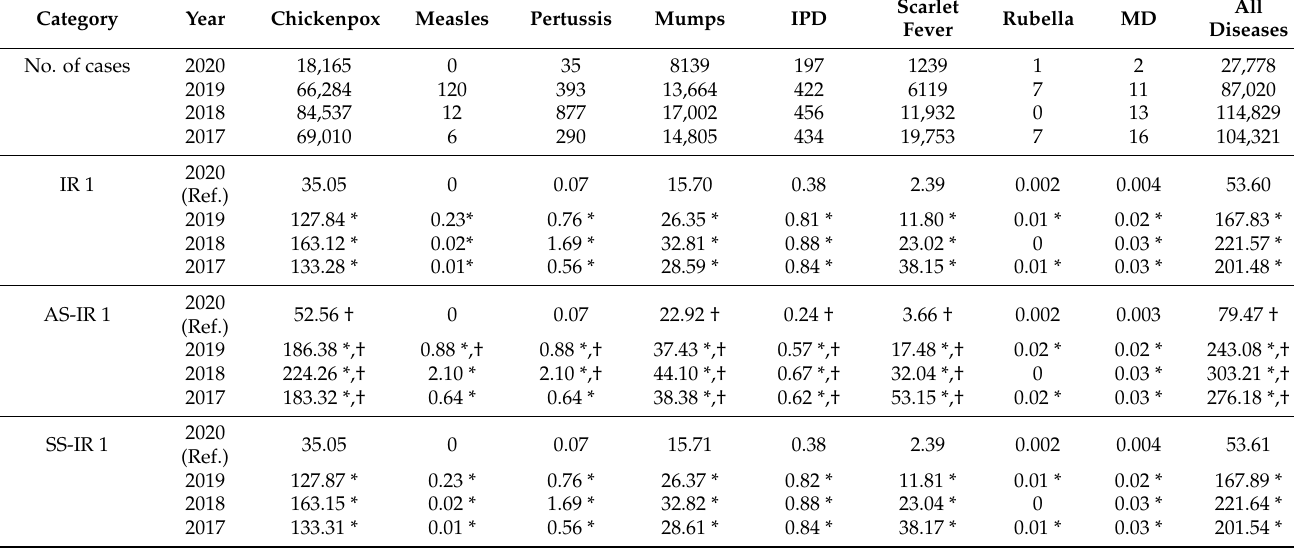
Table 2. Yearly IRs, AS-IRs, and SS-IRs of the eight infectious diseases in the intervention and pre-intervention periods. Category No. of cases